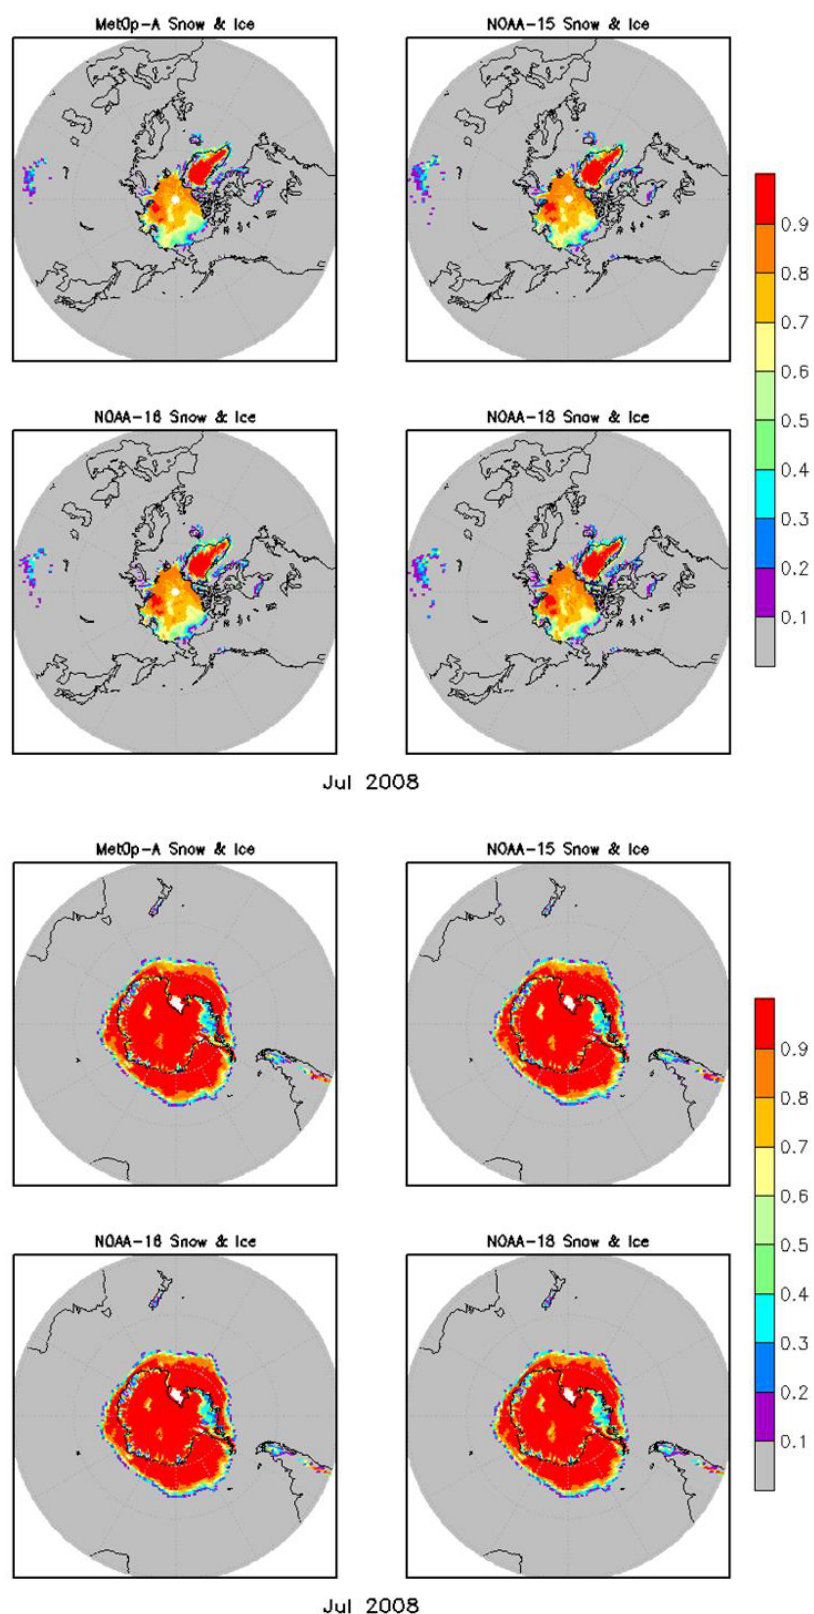
Figure 10. As in Figure 9, but for July 2008.